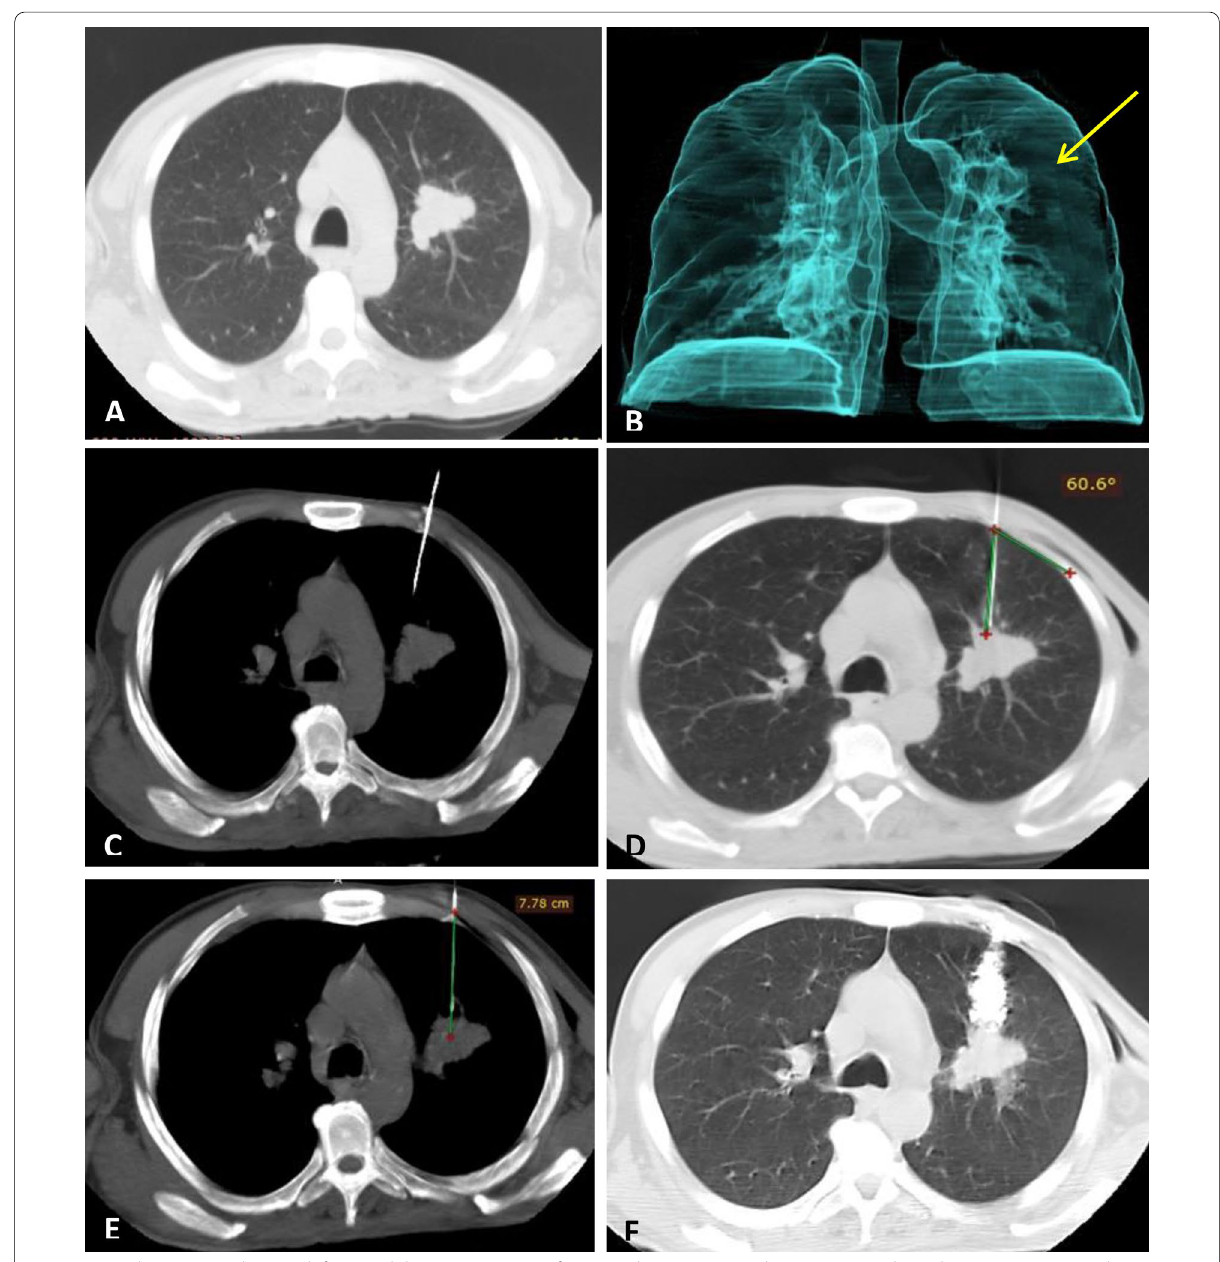
Fig. 2 A Axial CT images showing left upper lobe mass. B 3D VR of airways showing encased apicoposterior bronchus (arrow). C Coaxial pass out of trajectory. D Coaxial pass in trajectory, needle pleural angle 65 . Note developing surgical emphysema. E Coaxial pass in trajectory, biopsy track ◦ length 7.7 cm. F Gelfoam embolization of biopsy track with no